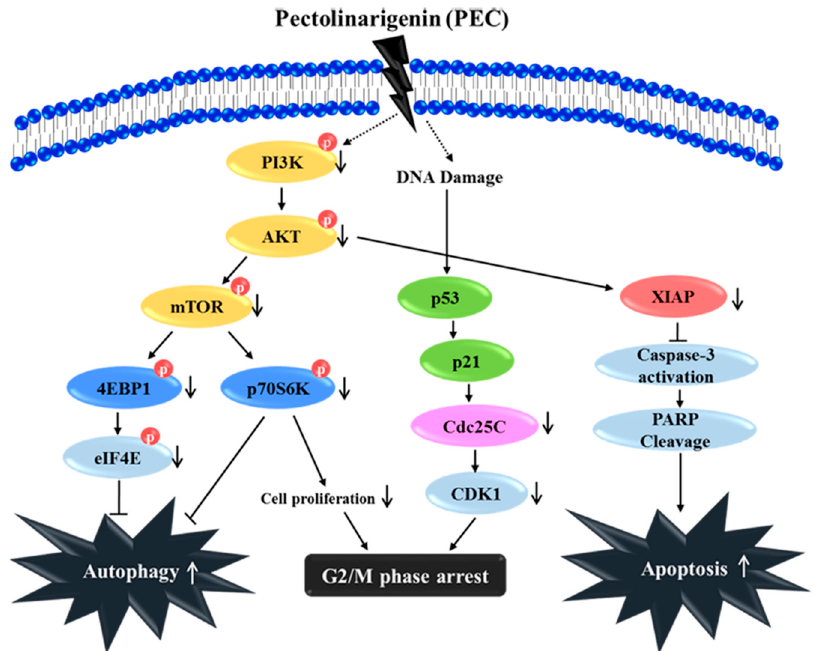
Figure 7. Schematic diagram characterizes the anti-cancer mechanism of the PEC treatment in both AGS and MKN28 cells. PEC induced G2/M phase arrest, autophagy, and apoptosis by down-regulation of PI3K/AKT/mTOR pathway, leading to the down-regulation of p-4E-BP1, p-p70S6K, and p-eIF4E. Altogether, PEC treatment has potential as a chemotherapeutic for the treatment of human gastric carcinoma.